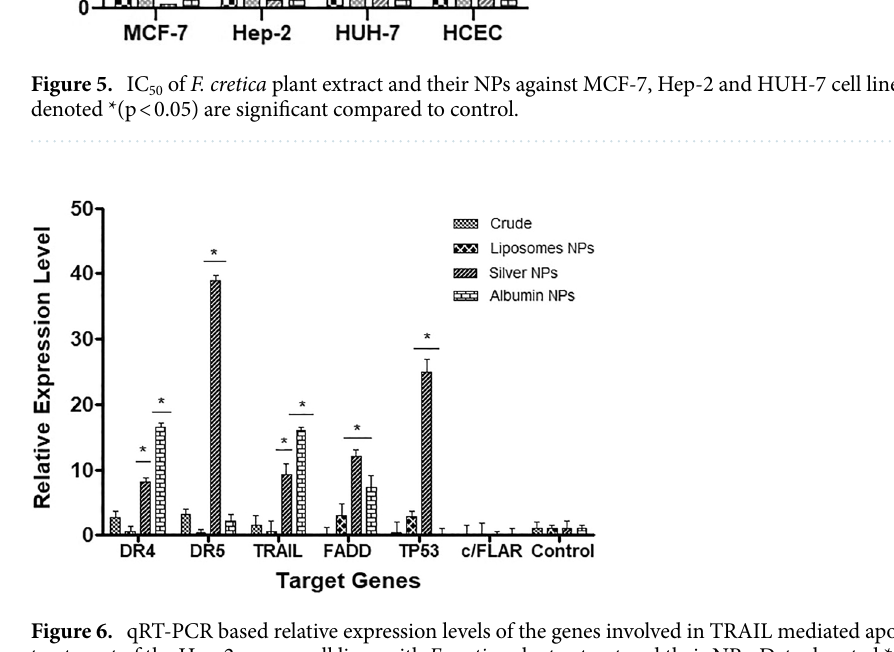
Figure 6. qRT-PCR based relative expression levels of the genes involved in TRAIL mediated apoptosis after treatment of the Hep-2 cancer cell lines with F. cretica plant extract and their NPs. Data denoted *(p < 0.05) are significant compared to control analyzed by one-way ANOVA with Dunnett’s multiple comparison